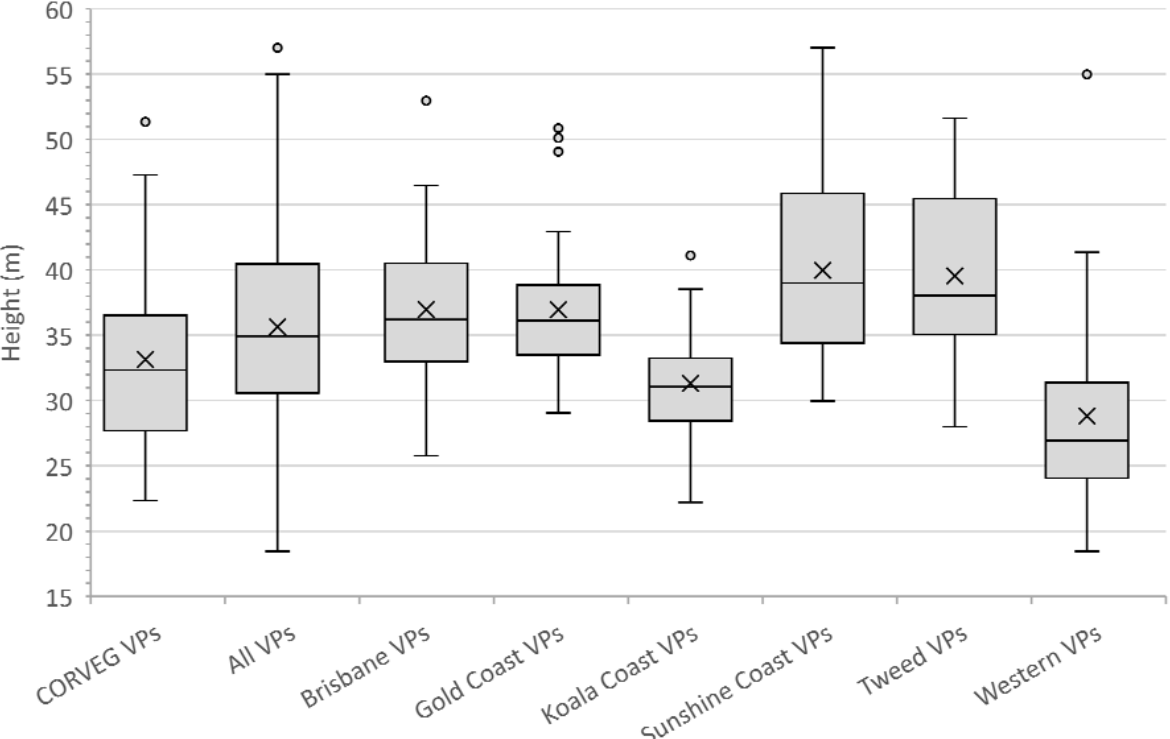
Figure 5. ALS virtual plot (VP) maximum tree heights for 33 Qld Herbarium CORVEG plots and 205 VPs from identified subregional areas in the Southeast Queensland Bioregion (SEQ).